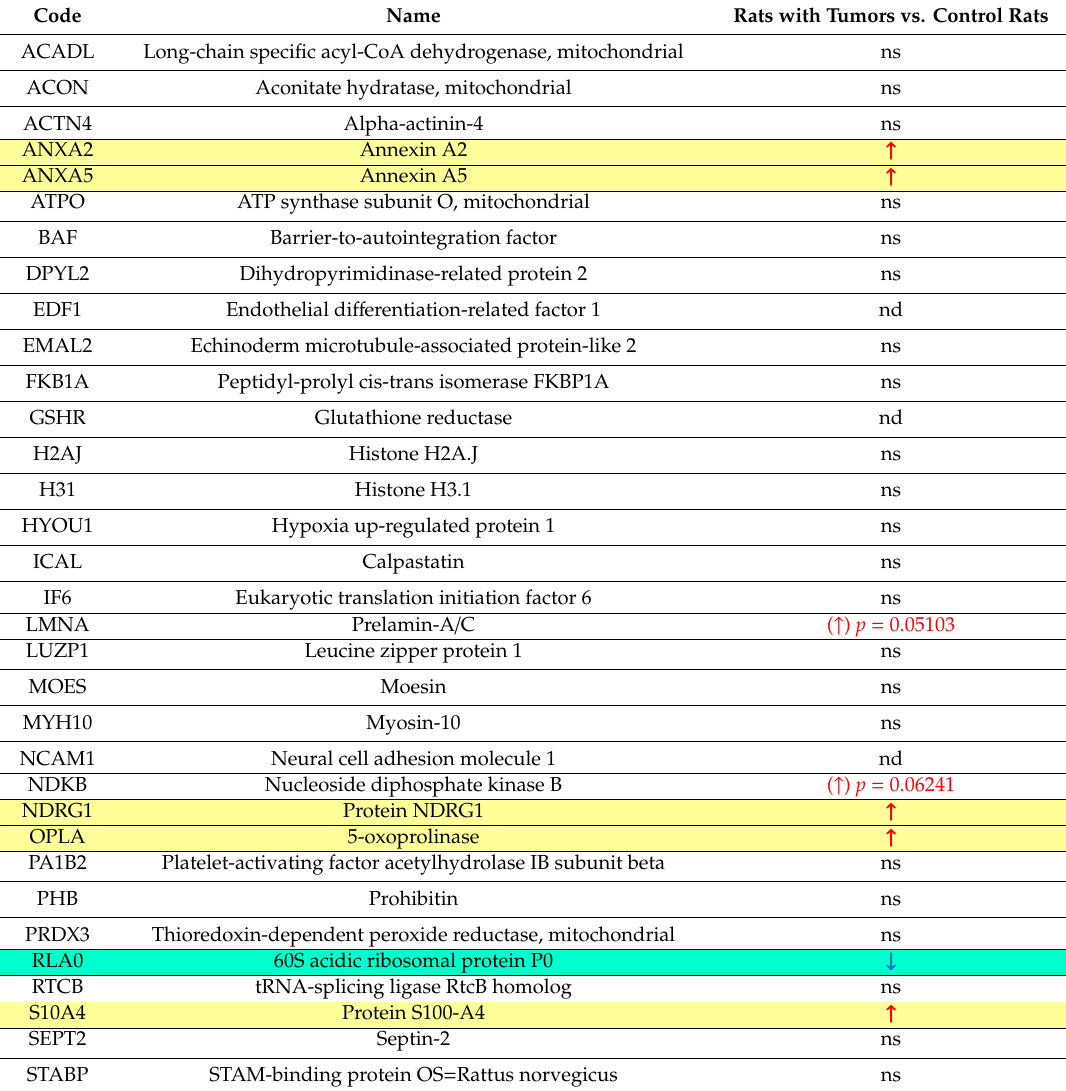
Table 3. Abundances of candidate biomarkers of tumor cell invasiveness in the spleens of rats with M5-T1 tumors relative to the spleens of control